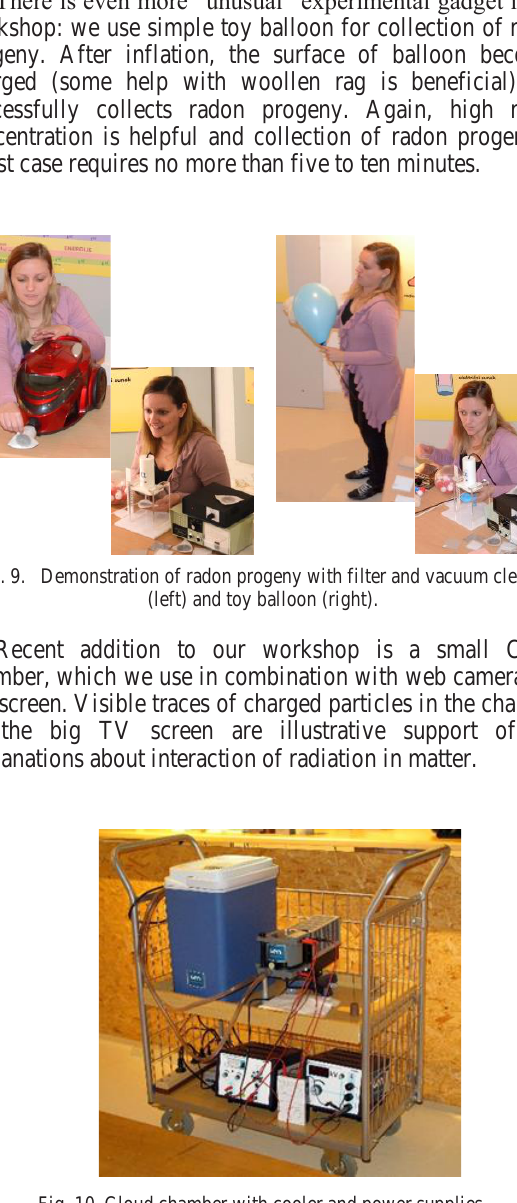
Fig. 10. Cloud chamber with cooler and power